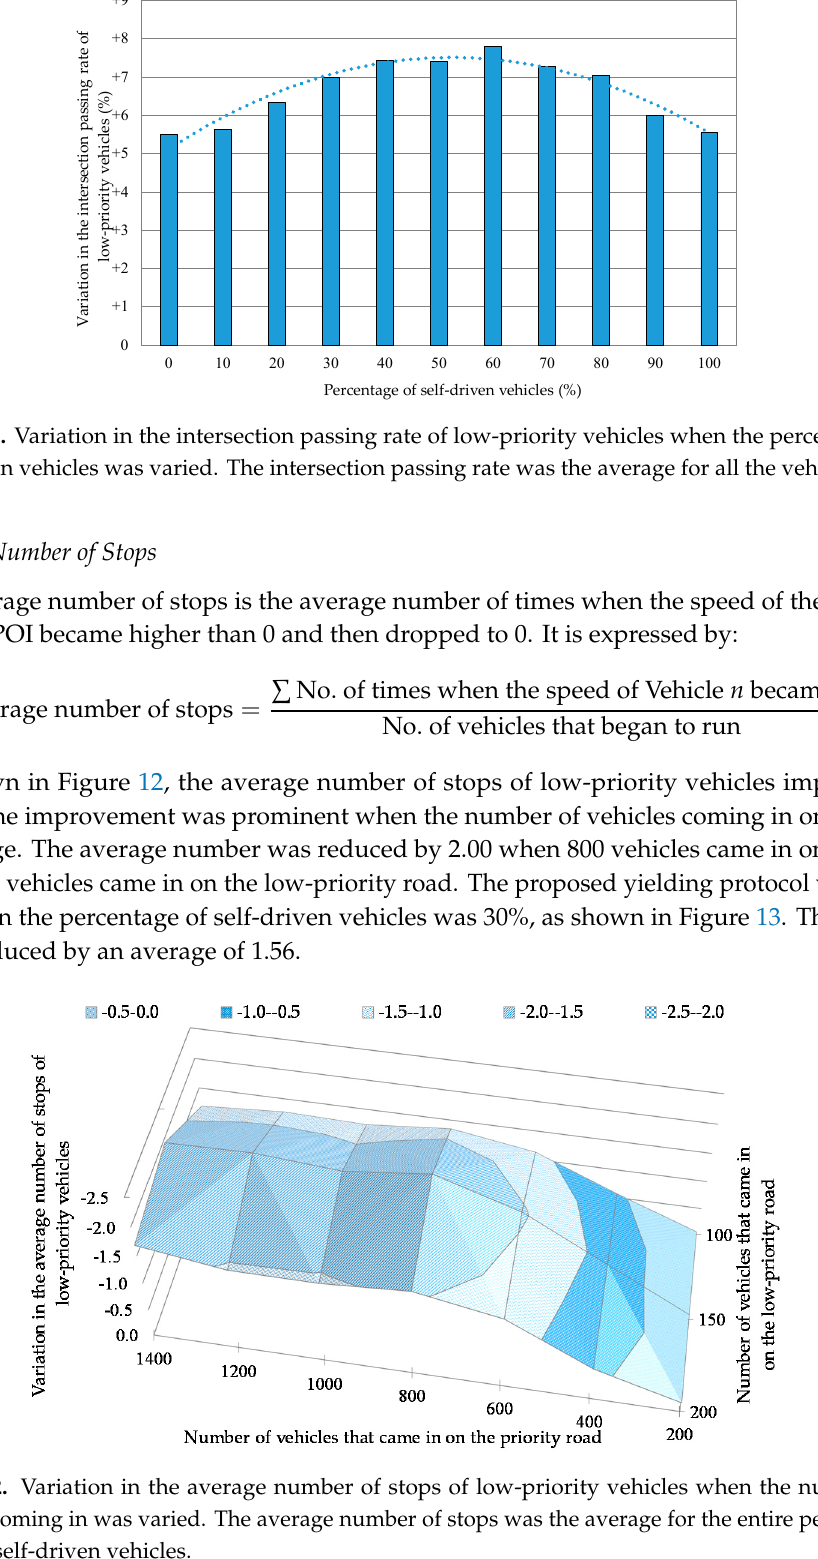
Figure 12. Variation in the average number of stops of low-priority vehicles when the number of vehicles coming in was varied. The average number of stops was the average for the entire percentage range of self-driven vehicles.